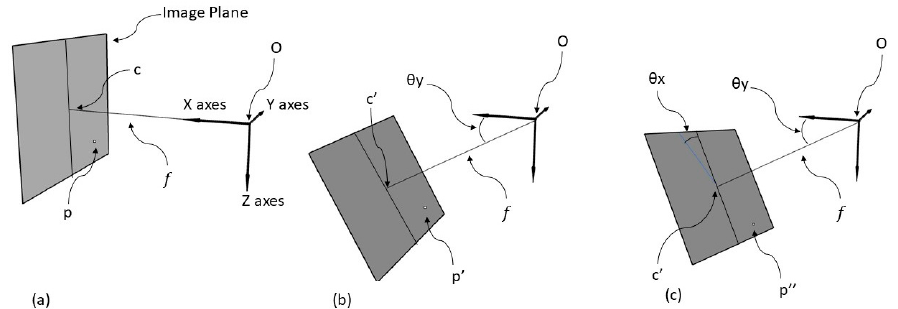
Figure 3. Camera is in an initial state comparable to the inertial frame ( θ x = θ y = θ z = 0) ( a ). Black arrows represent the camera axes. The point O is the camera center and the origin of the local coordinate systems defined for this model; f is the focal length of the camera (oriented along the X axis); c is the image center; p is a generic point in the image plane. In the proposed model the Yaw angle ( θ z) is always equal to zero, therefore no system rotation is applied. The Pitch ( θ y) rotation around the Y axes and it generates the state represented graphically in ( b ). The Roll ( θ x) rotation needs to take place around the axes defined by O-c ′ and generates the state represented graphically in ( c ). (Source: personal collection).